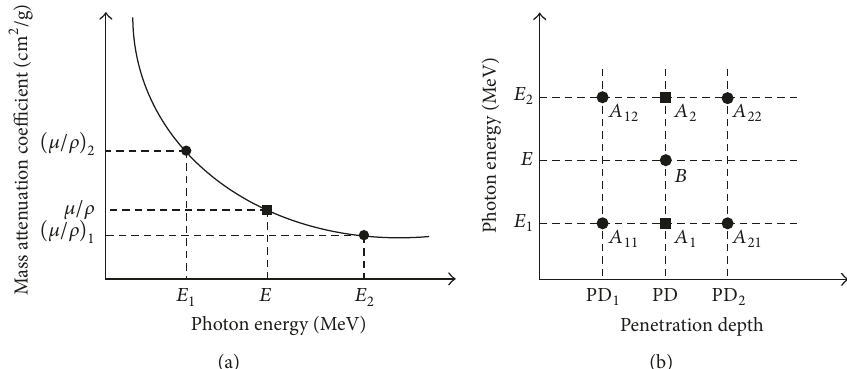
Figure 2: Method of interpolations: (a) logarithmic interpolation and (b) bilogarithmic